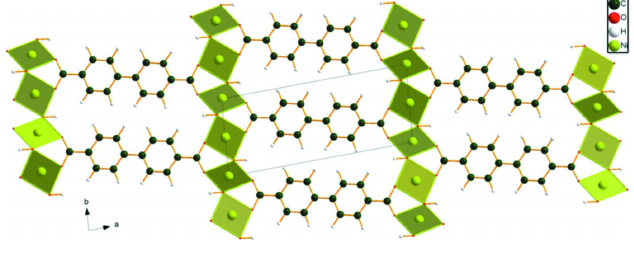
Figure 9 Crystal structure of Ni 2 (BPDC)(OH) 2 , viewed down the c -axis. Image generated using DIAMOND (Crystal Impact, 2022).